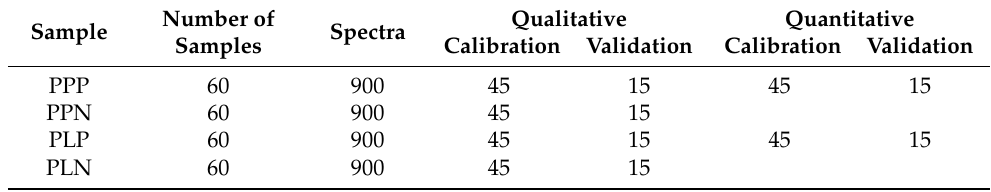
Table 5. Sample statistical